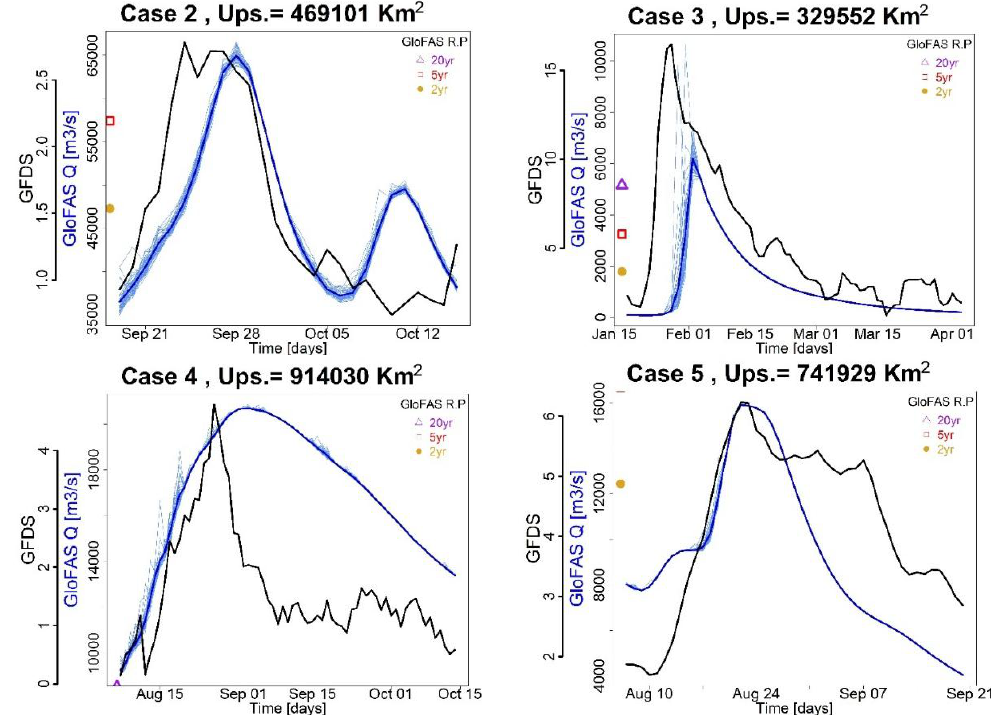
Figure 5. Time series of the probabilistic ensemble GloFAS forecast at five day lead-time [51] ensemble members (blue) and ensemble mean (dark blue), and the time series of the detected GFDS magnitude (black) during the days that the reported flood period by DFO. For information, the GloFAS upstream area is displayed for each location as well as the two-, five-, and 20-year return